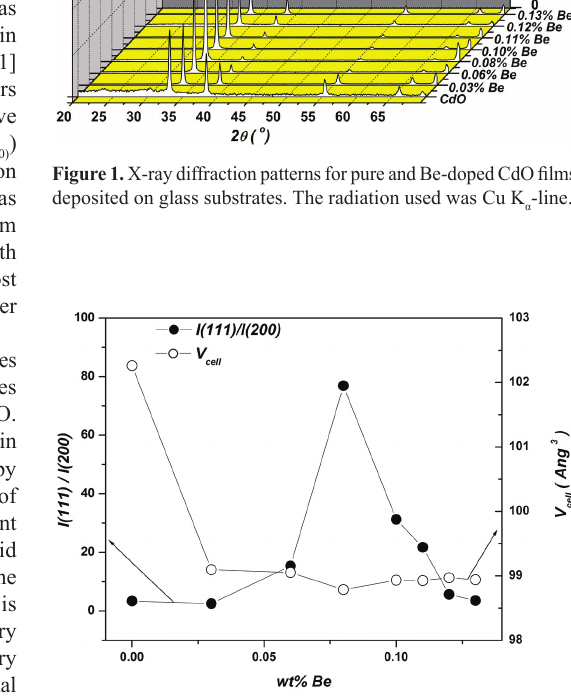
Figure 2. The variation of host CdO unit cell volume and ratio I(111)/I(200) with Be doping